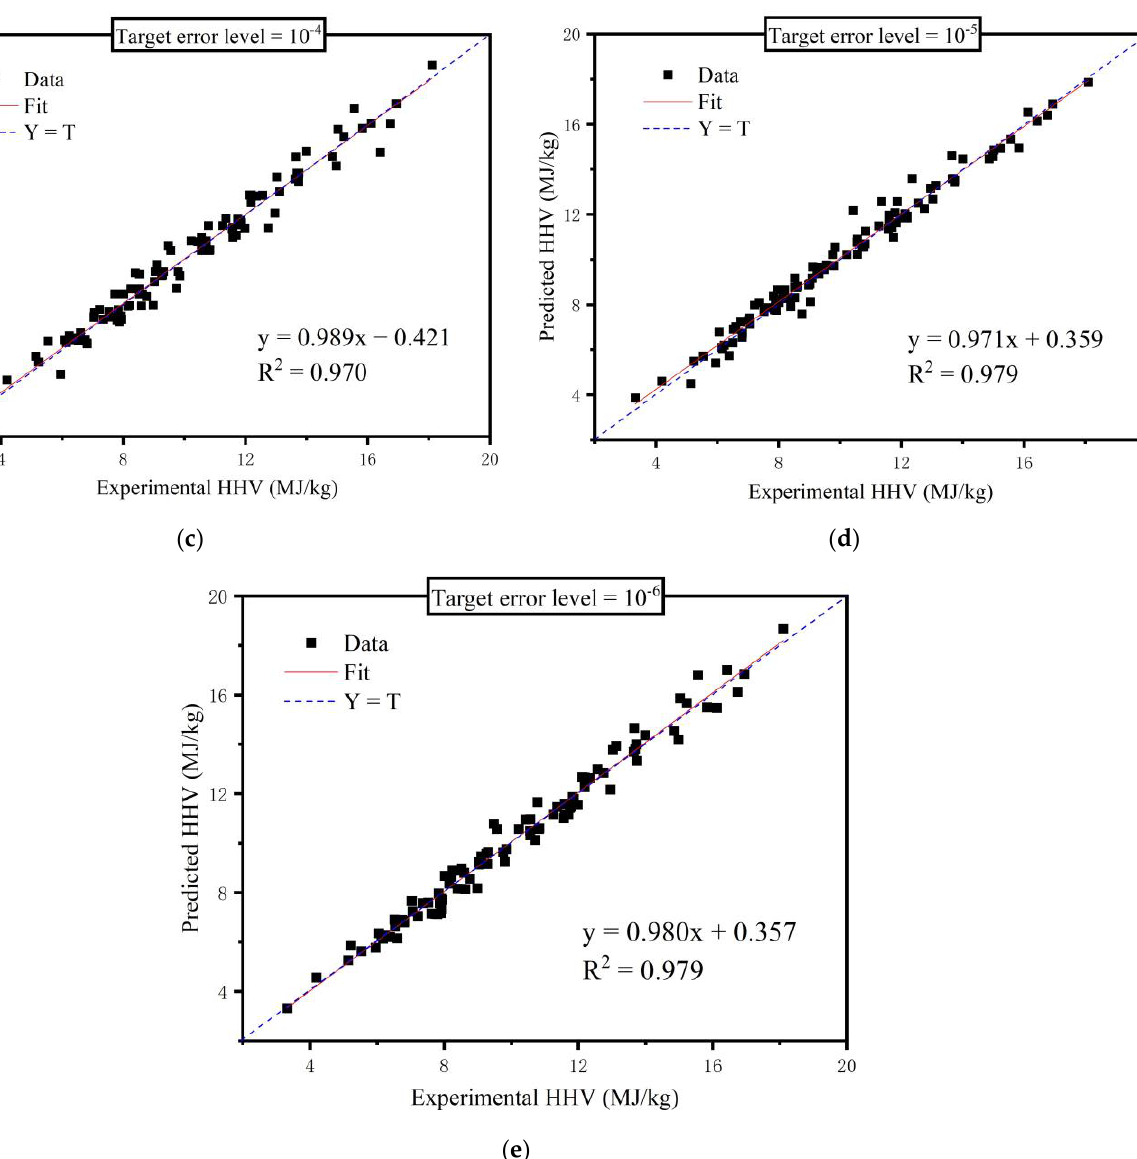
Figure 7. Network simulation results with different target error level: ( a ) indicates the situation where the target error level is 5 × 10 − 3 ; ( b ) indicates the situation where the target error level is 10 − 3 ; ( c ) indicates the situation where the target error level is 10 − 4 ; ( d ) indicates the situation where the target error level is 10 − 5 ; ( e ) indicates the situation where the target error level is 10 − 6 .